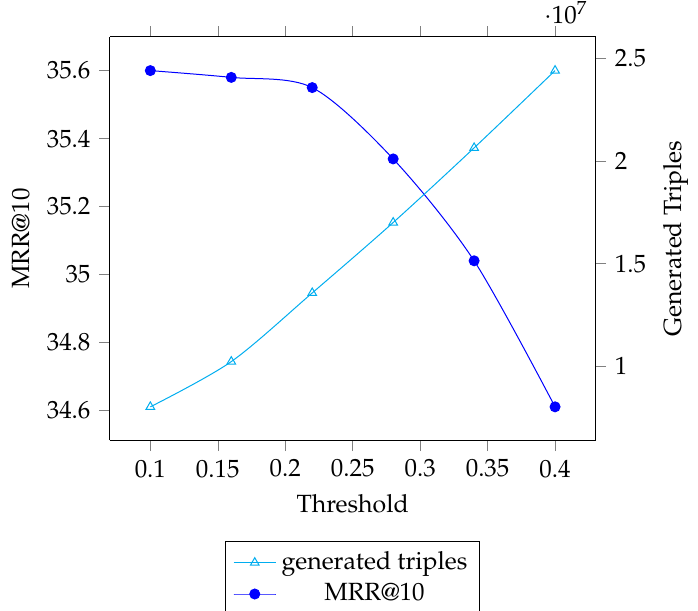
, which present A